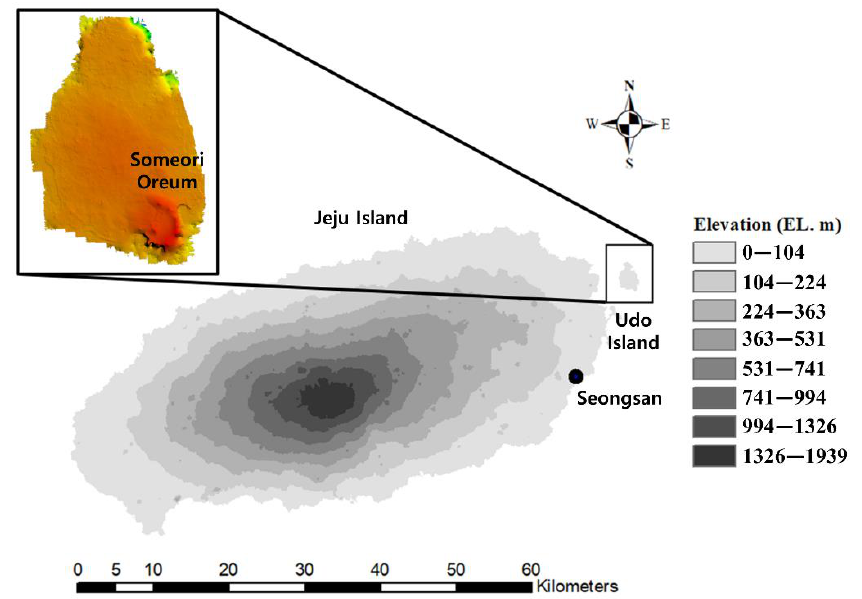
Figure 3. Location of Udo and its topographic map. The meteorological data of Seongsan weather station were used in this study to represent the weather on Udo.